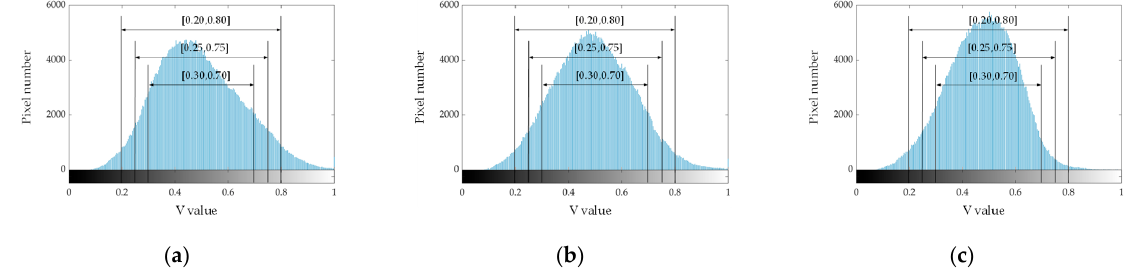
Figure 10. V value distribution histogram under light irradiation. ( a ) Single-sided-strip LED; ( b ) double-sided-strip LED; ( c ) central-ring LED. Table 4. V value distribution indicator.